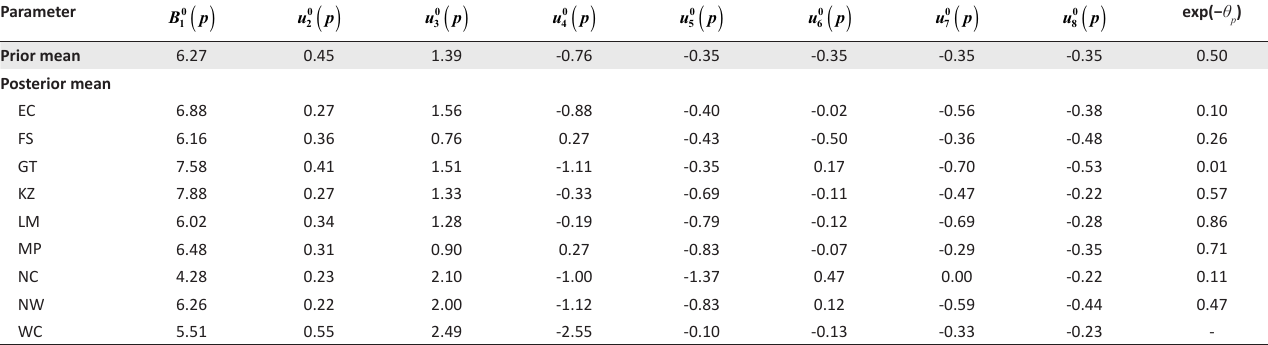
TABLE 1: Prior and posterior means for Step 2 (adults and children combined).